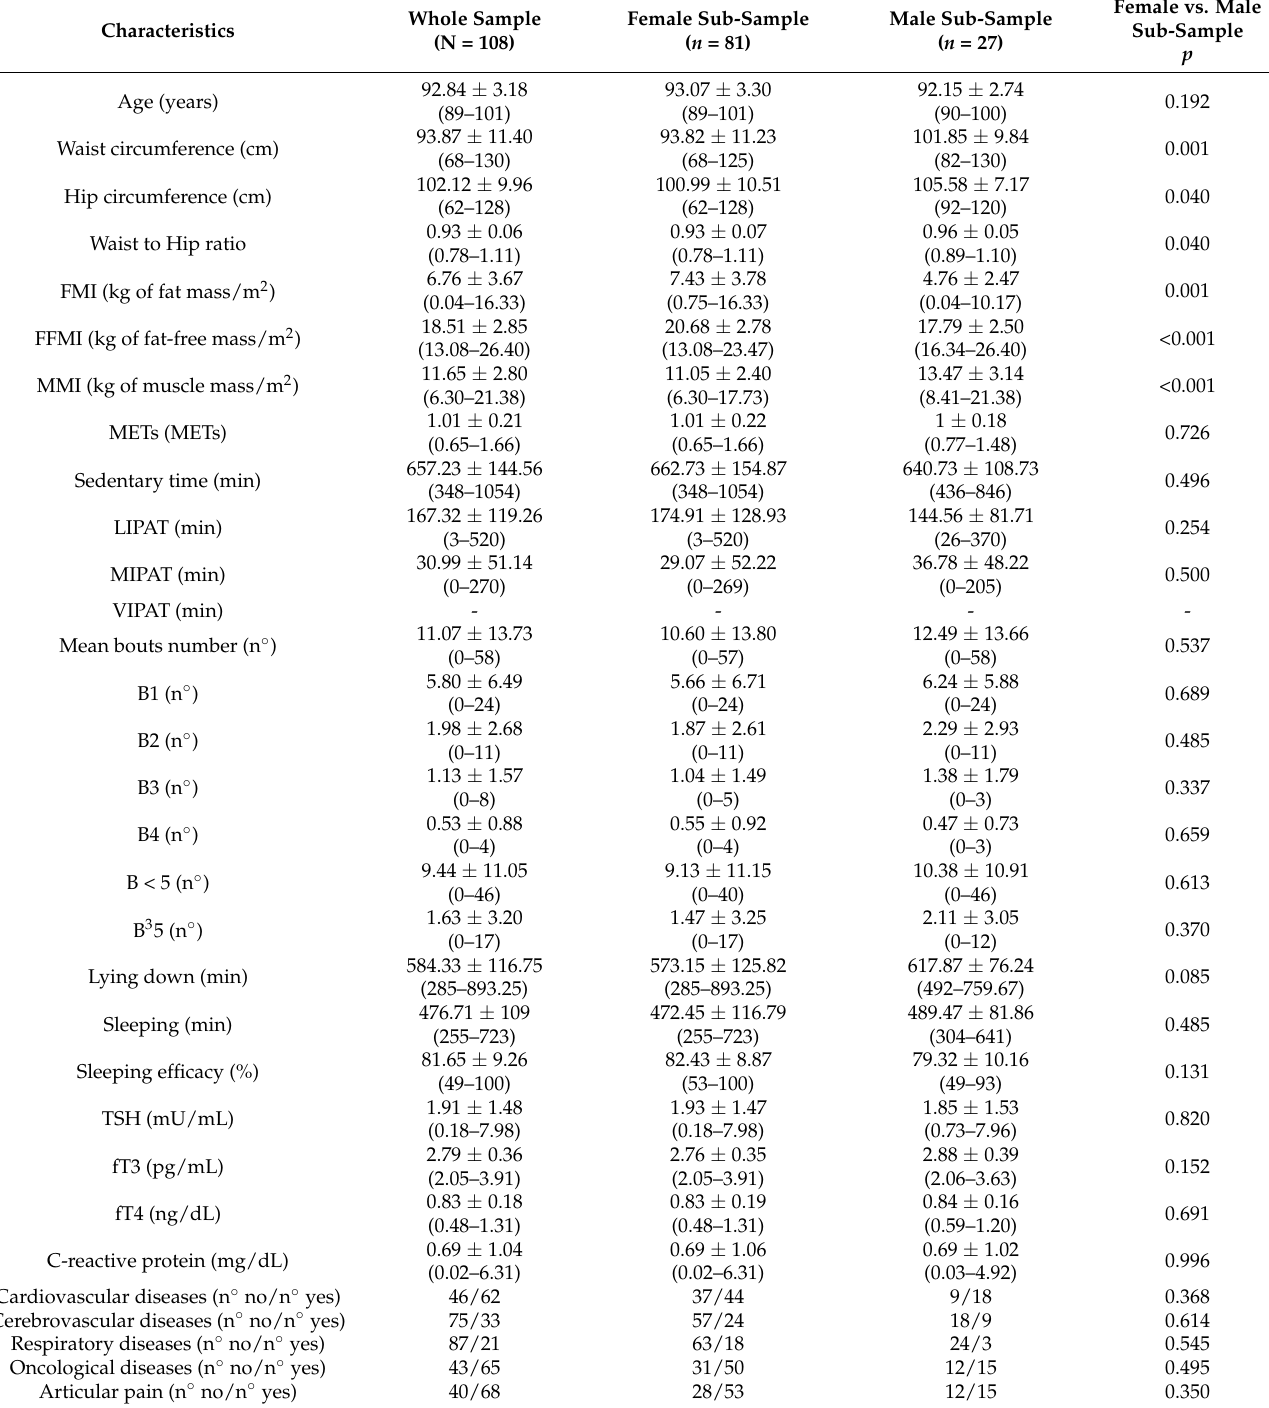
Table 1. Characteristics of the study population and sub-samples